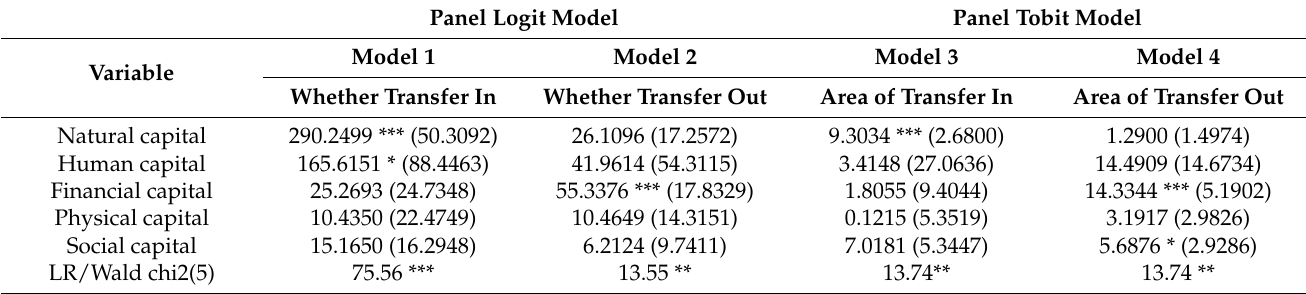
Table 5. Regression results of livelihood capital and land